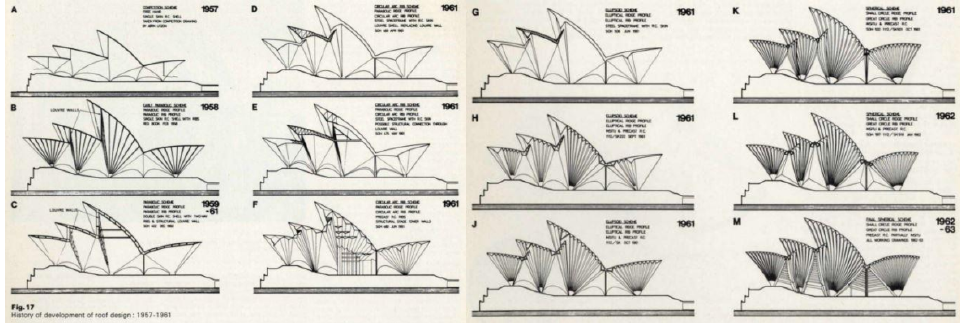
Figure 8. Temporal evolution of the different alternatives studied for the roof structure ( The Arup Journal , 1973)